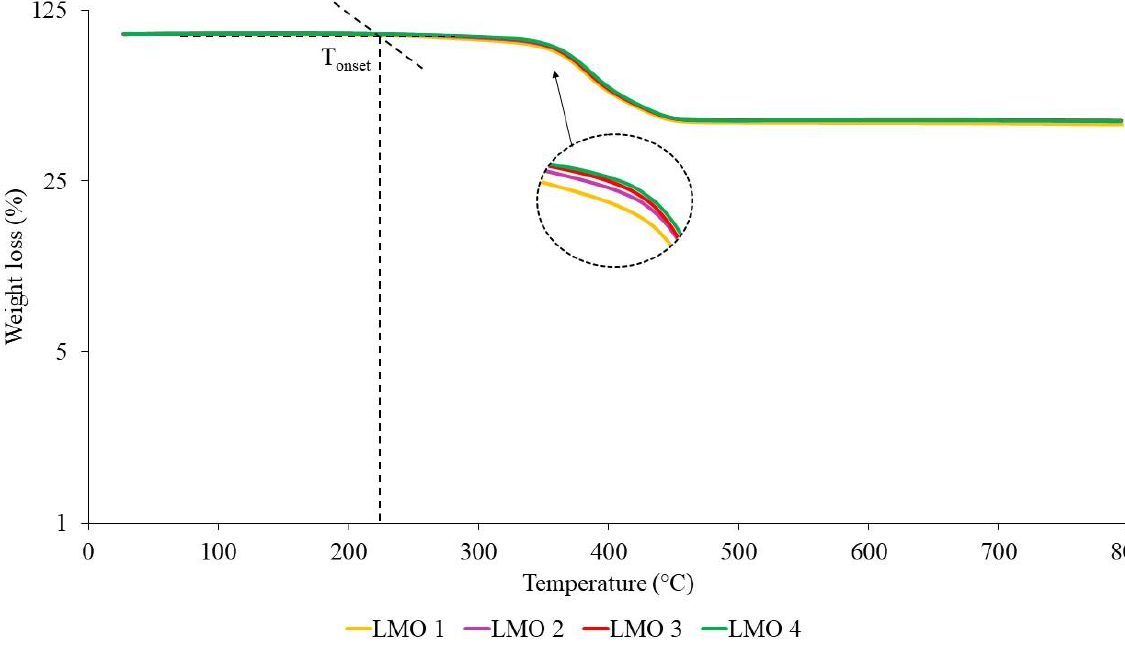
Figure 11. TGA curves of NR-based MREs for different ratios of LMO:AO.